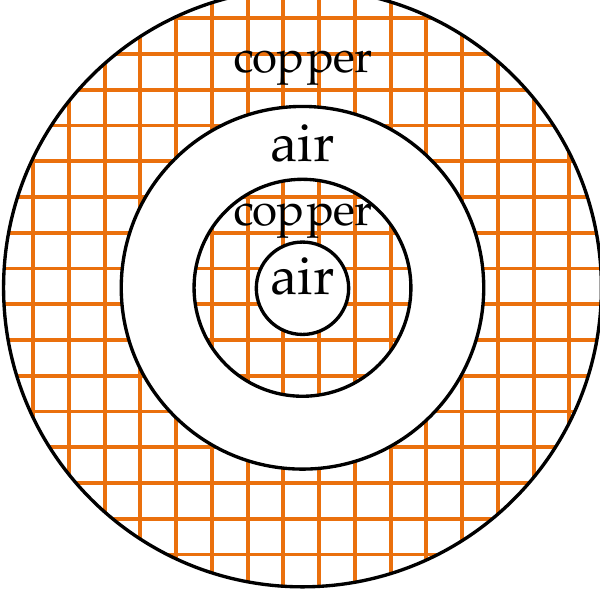
Figure 4. The ‘thick wall’ coaxial waveguide used in example 2.